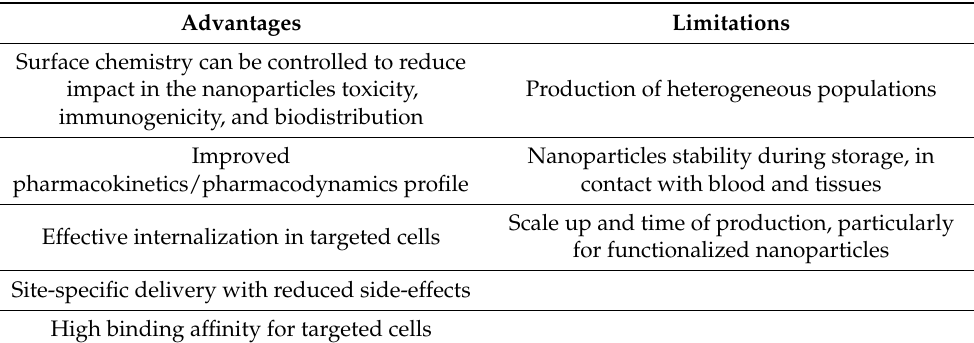
Table 3. A resume of the advantages and limitations of mannose receptor-targeting polymeric